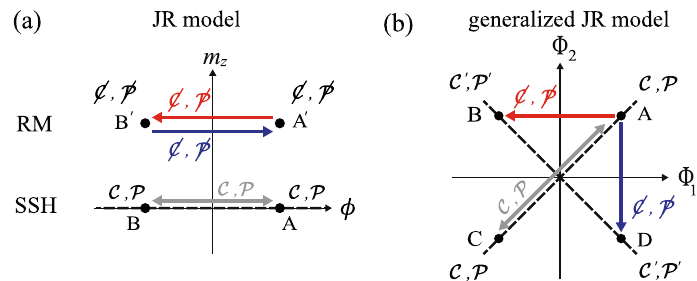
Figure 3. Diagrams for C and P symmetries of global minima and solitons for the ( a ) JR and ( b ) generalized JR models. C and P indicate the symmetries, while C / and P / do broken symmetries. The dashed lines represent C and P symmetry-invariant lines. In ( a ), the φ axis and the symmetry-invariant line are overlapped. The gray arrow represents solitons in the SSH model, and red and blue arrows do in the RM model. A and B ( A ′ and B ′ ) are two degenerate vacua for the SSH (RM) model. In ( b ), the prime in superscript represents that the corresponding symmetry transformation has a different form comparing with the unprimed one. The red, blue, and gray arrows represent right-chiral, left-chiral, and non-chiral solitons,